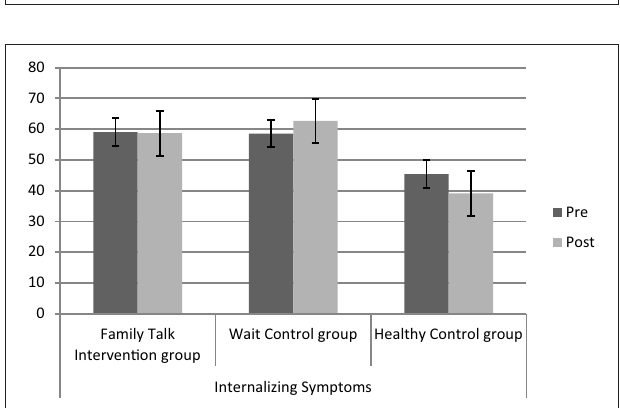
FIGURE 2 | Levels of externalizing symptoms (T-scores) before (pre) and after (post) the intervention for the three different groups (IG, WCT, CG).